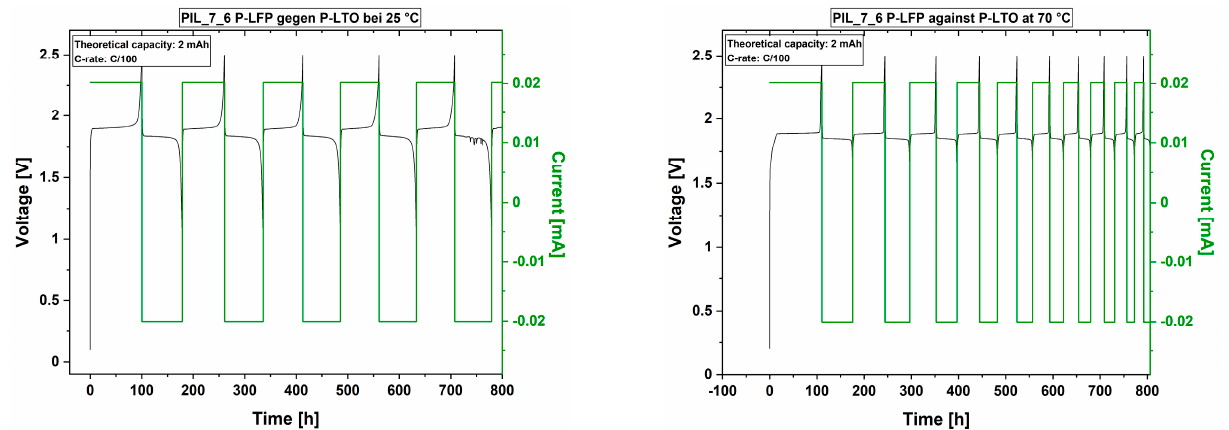
Figure 9. First 10 cycles of the cell test of the polymer electrolyte with 100% EC as liquid electrolyte (PIL_7_6) at 25 °C ( left ) and 70 °C ( right ) and lithium iron phosphate against lithium titanate electrodes at C/100. Images including all executed cycles are given in the Supporting material section (Figure S6).